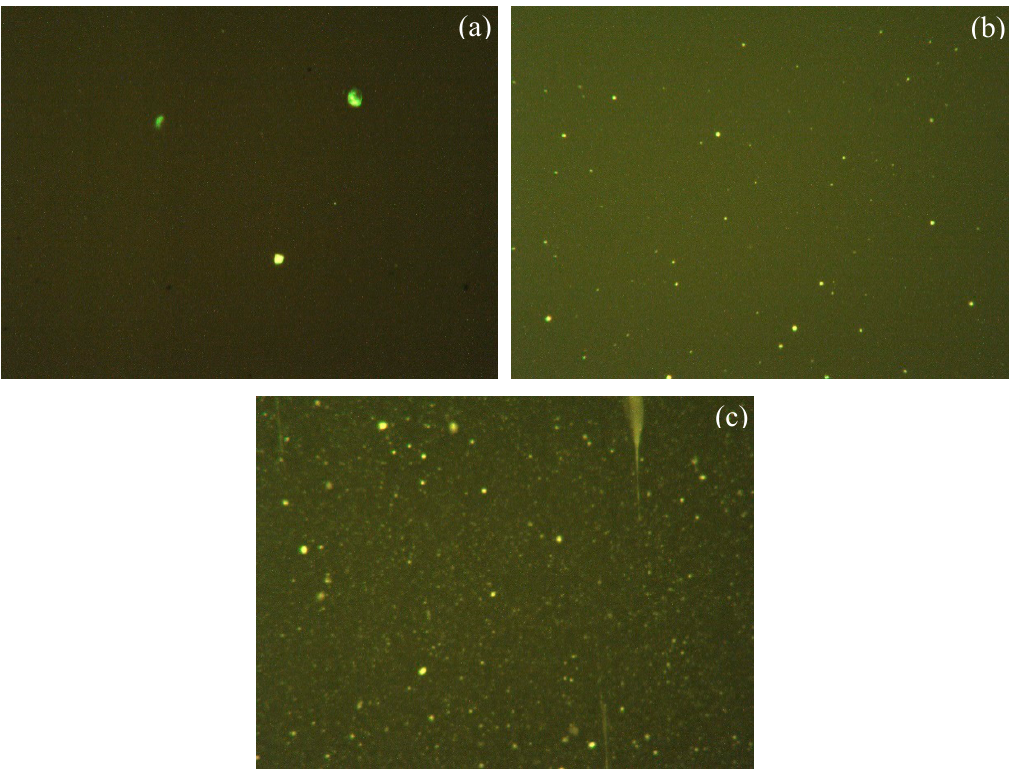
Figure 15. FM pictures of bitumen from R-UL, R-ML, and R-BL (100 × ): ( a ) R-UL; ( b ) R-ML; and ( c ) R-BL.